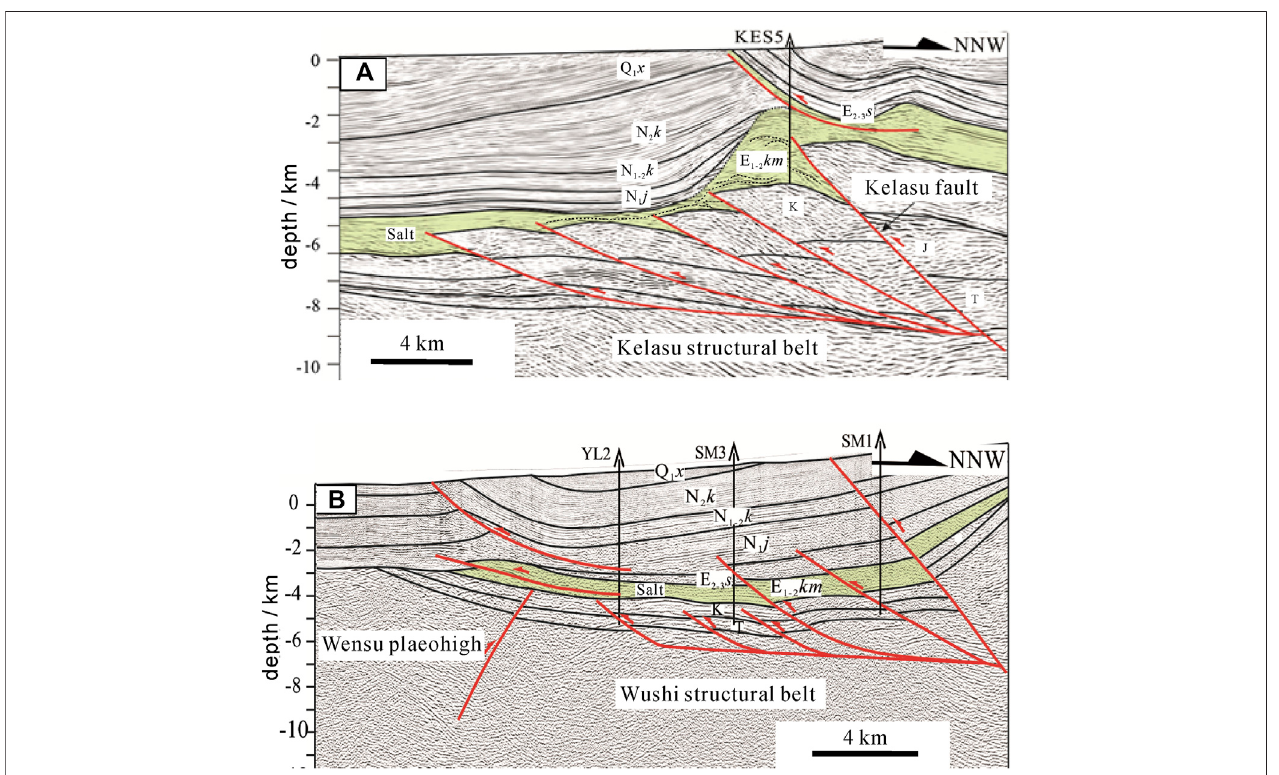
FIGURE 8 | Structural deformation characteristics caused by the differential thickness of the salt layer in (A) the Kelasu structural belt and (B) the Wushi structural belt; seismic pro fi les cited from Yang (2017).